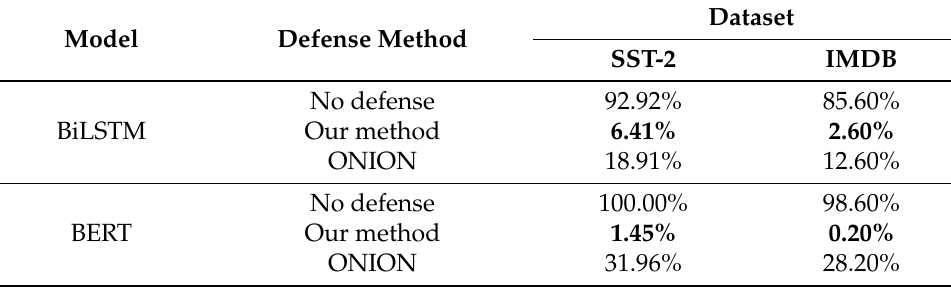
Table 3. Defense performance against character-level backdoor attack